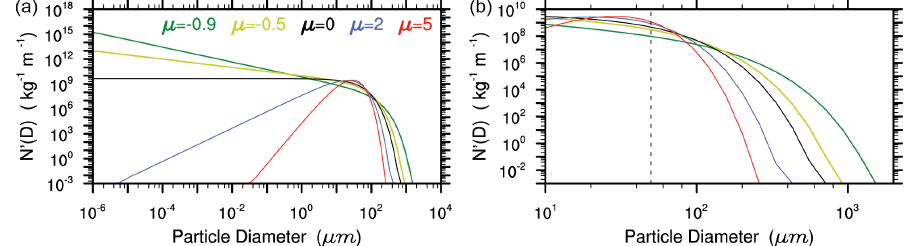
Figure A1. The particle number densities ( N (cid:48) , which is a function of D ) calculated from the gamma distributions with various µ values. Here, the total particle number and mass-weighted diameter are set to 10 5 kg − 1 ( ∼ 50L − 1 ) and 40µm, respectively. Note different markers in the y axis and x axis between the left column and right column. The vertical black line indicates D = 50µm.